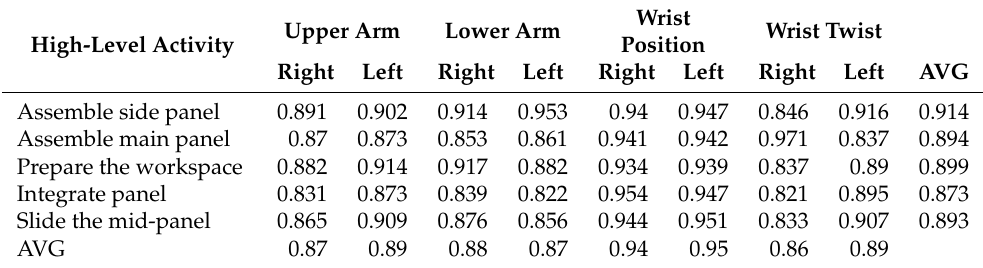
Table 6. Similarity measurement results for section A (Max score).